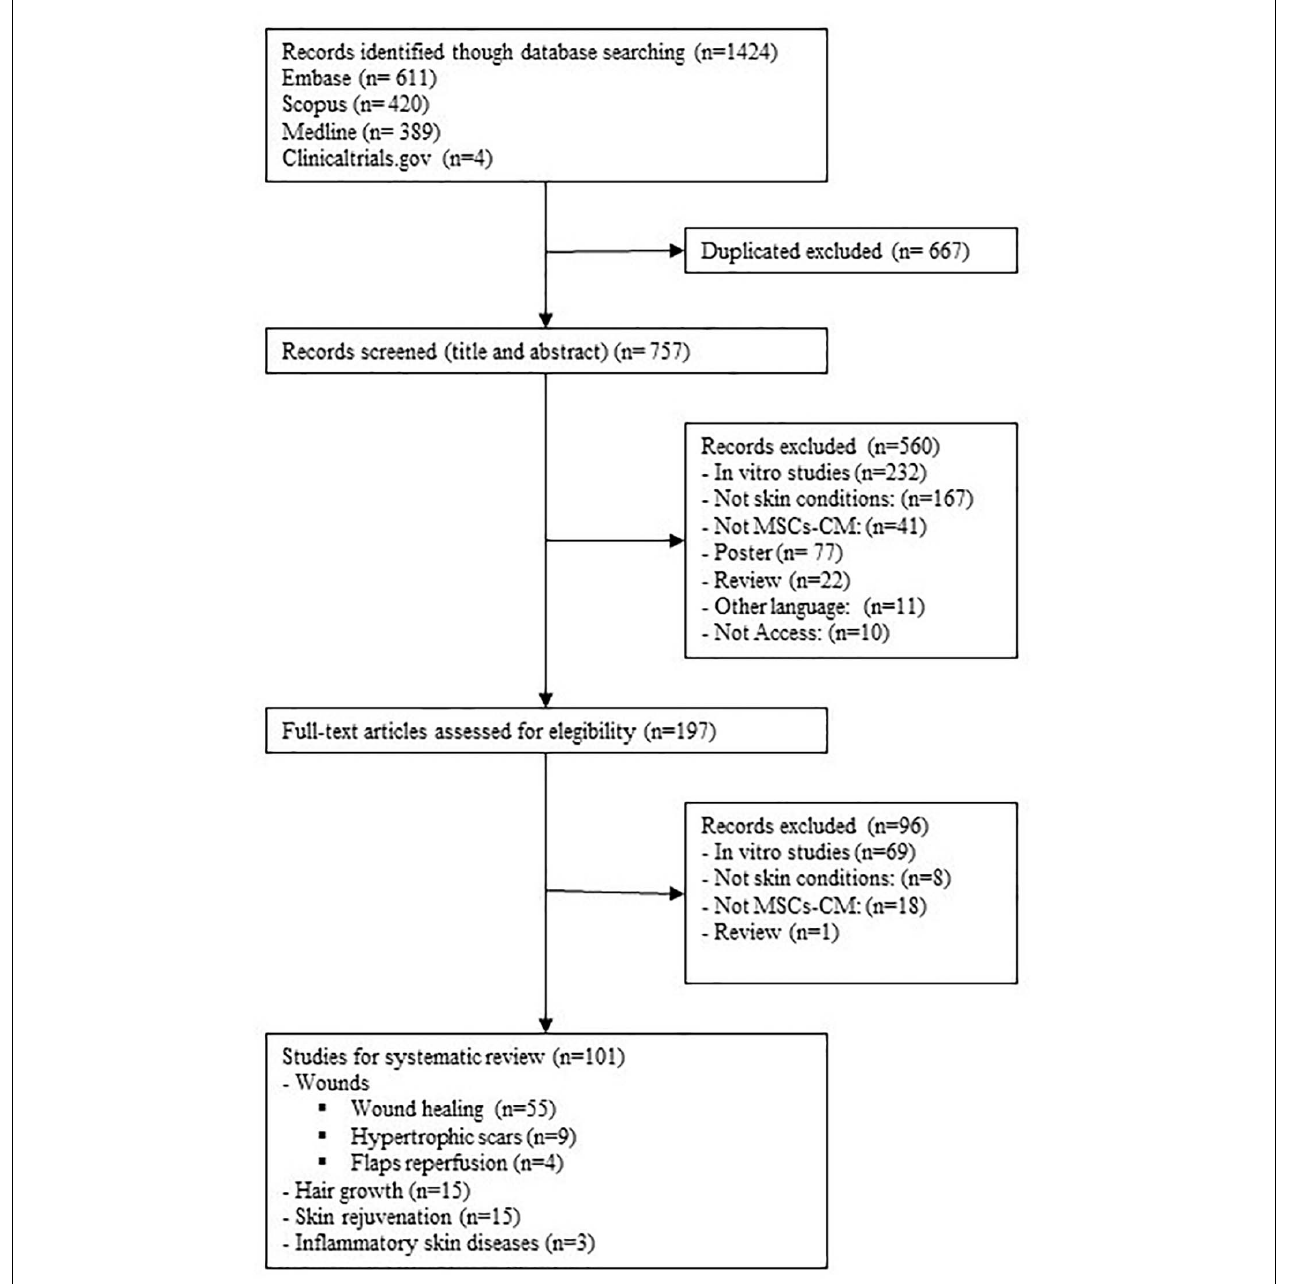
FIGURE 1 | Flow diagram of the study selection process.